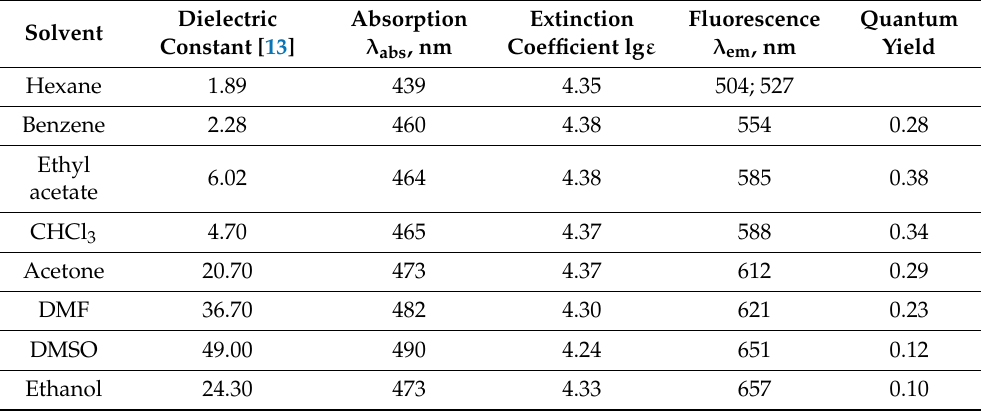
Table 1. Photophysical parameters of studied derivative 2 in various solvents (concentration is 1 × 10 − 5 mol L − 1 ).